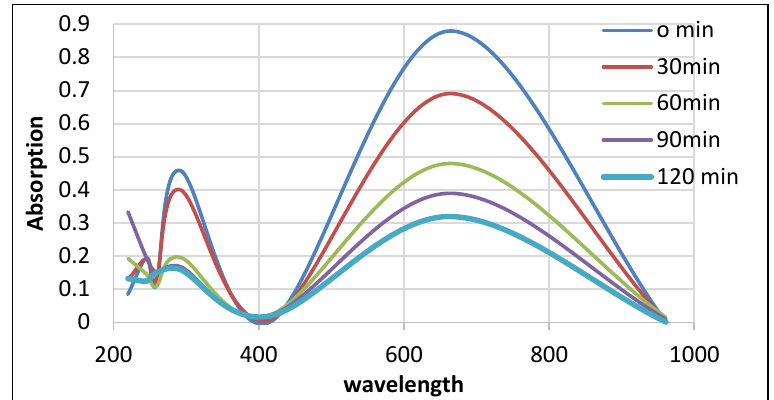
Fig. 6: Absorption spectra of MB dye without catalysis under sunlight irradiation.